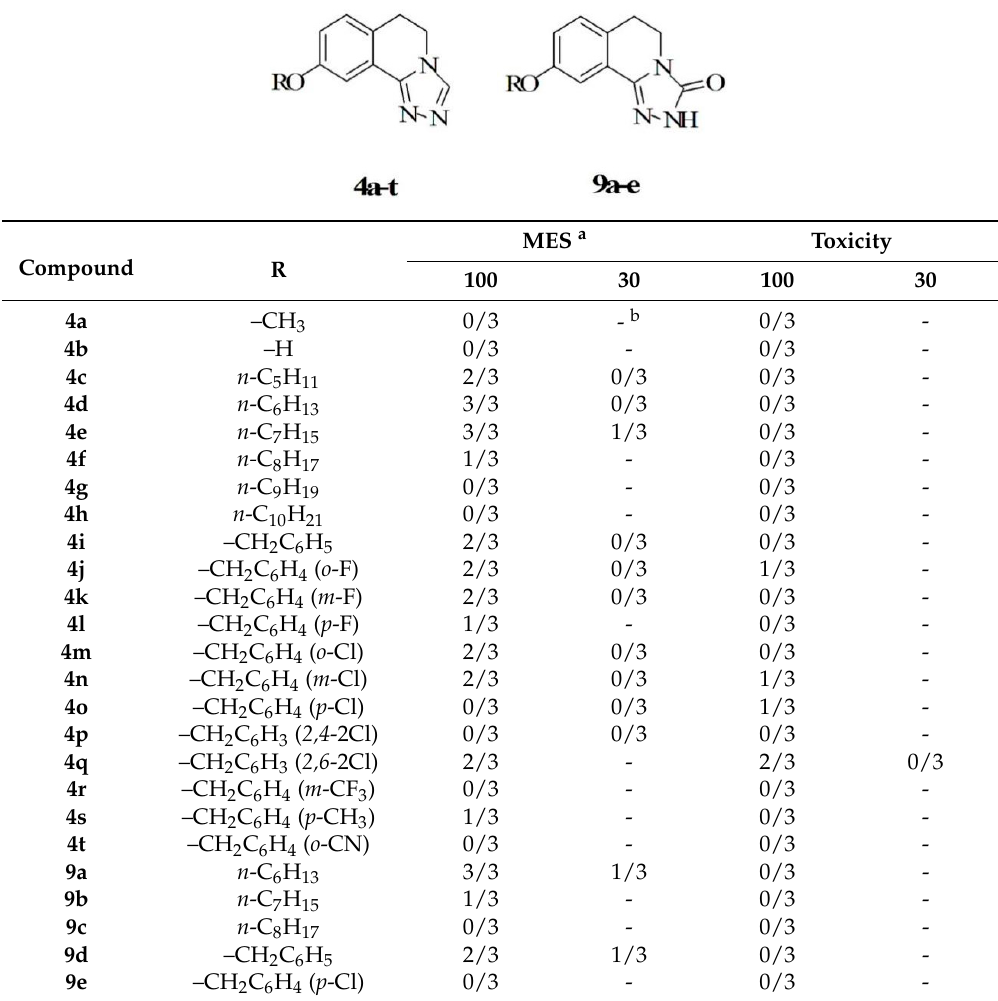
Table 1. Phase-I evaluation of anticonvulsant activity in mice (i.p.).